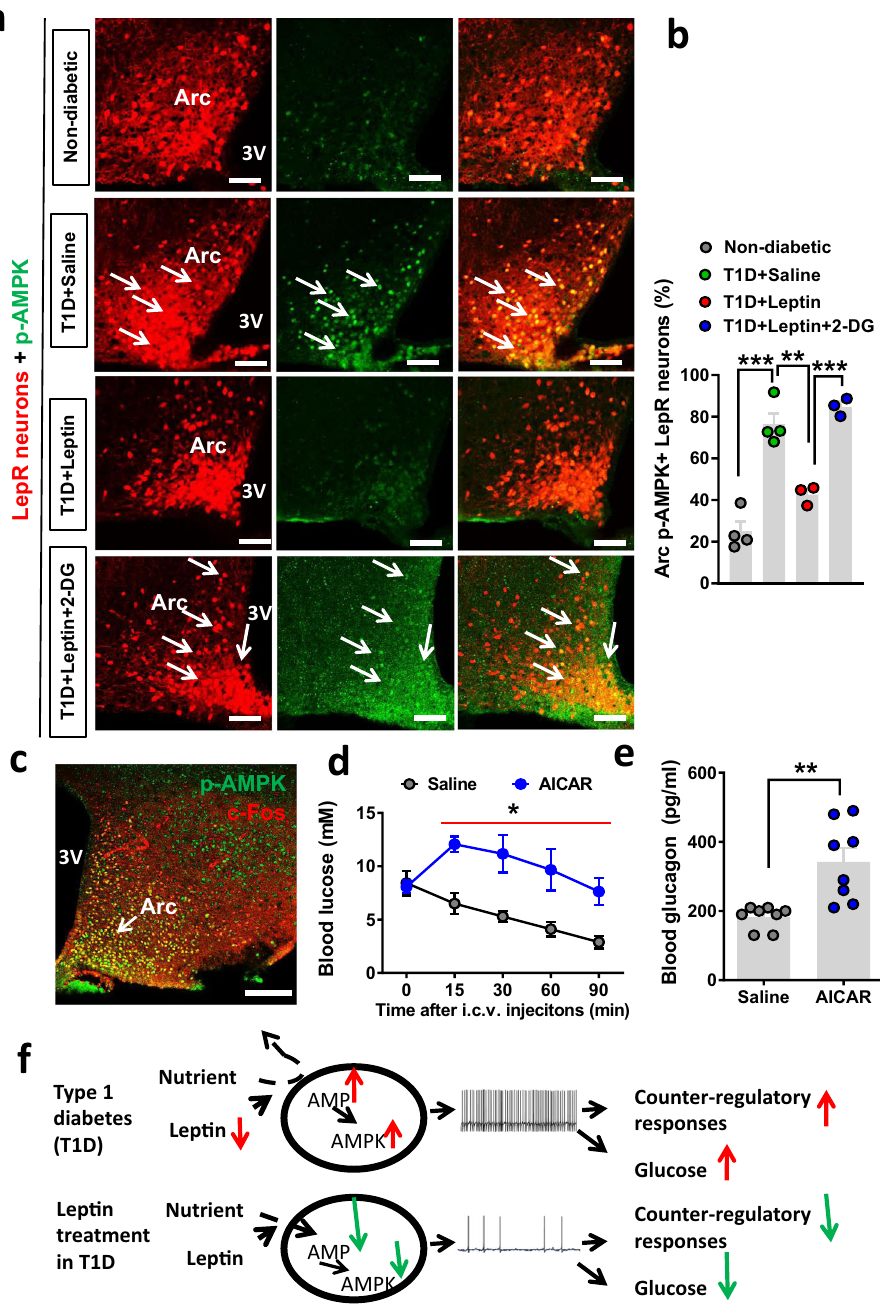
Fig. 7 T1D hyperglycemia and leptin action on reducing T1D hyperglycemia involve the AMPK pathway. a Representative immunostaining images from n = 3 – 4 mice as shown in b for p-AMPK in hypothalamic sections were shown from control ( a , Non-diabetic), T1D with saline treatment ( a , T1D + saline), T1D with leptin treatment ( a , T1D + leptin), and T1D with both leptin and 2-DG treatments (T1D + leptin + 2-DG) at fed conditions. b Comparison in the percentage of LepR Arc neurons with p-AMPK expression among the four groups (one-way ANOVA, n = 4 for nondiabetic controls and T1D-saline and n = 3 for T1D-leptin and T1D-leptin-2-DG, F (3, 10) = 42.27, *** P < 0.0001, nondiabetes vs T1D-saline; ** P = 0.0051, T1D-saline vs T1D-leptin; *** P = 0.004, T1D-leptin vs T1D-leptin-2_DG). c Representative pictures from n = 1 mouse showing colocalization between p-AMPK (green) and c-Fos (red) in the Arc of T1D LepR-Cre mice. d , e Wild-type mice (8 – 9 weeks of age, males) were made T1D and then i.c.v. treated with leptin to restore euglycemia. These mice were then treated with i.c.v. injections of either saline or AICAR, an agonist of AMPK. Comparisons in blood glucose were shown following i.c.v. AICAR ( d , two-way ANOVA, n = 3/each, F (1, 20) = 35.91, * P = 0.0374, saline vs AICAR at the 90-min time point) and in blood glucagon at 90 min after AICAR injection ( e , two-tailed unpaired Student ’ s t tests, n = 8/each, t = 3.862, df = 14; n = 9/each, ** P = 0.0017). f Diagram depicting hyperglycemia in T1D caused by heightened Arc GABAergic neuron activity due to energy deprivation and low leptin levels (top) and euglycemia restoration by leptin inhibition of neuron activity through reversing energy deprivation (bottom). 3: the third ventricle and Arc: arcuate nucleus. Data presented as mean ± SEM. 3V the third ventricle, Arc arcuate nucleus; Scale bar: 100 µ